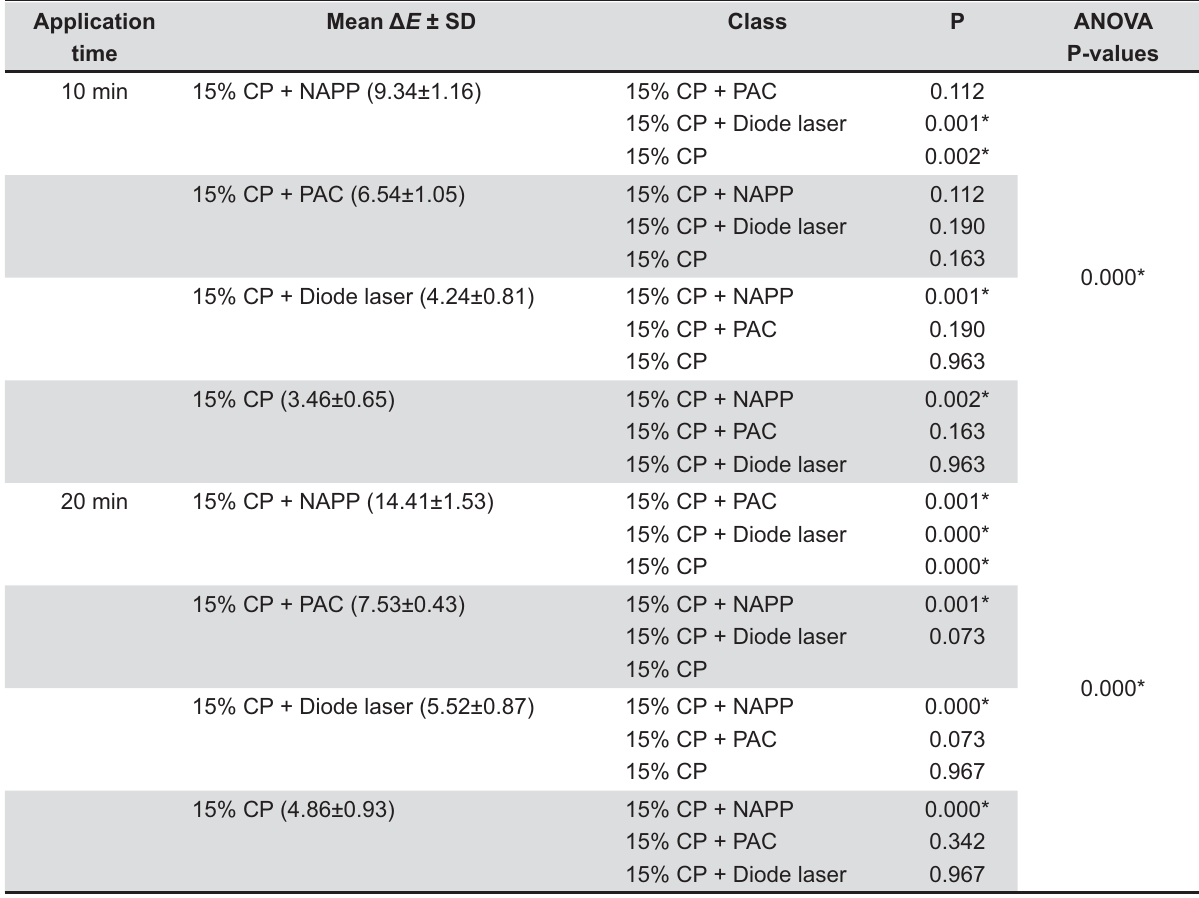
Table1- (cid:7)+(cid:5)(cid:13)(cid:7)(cid:23)(cid:13)(cid:14)(cid:15)(cid:7)(cid:20) E ±SD (standard deviation) after tooth bleaching using different light sources Application